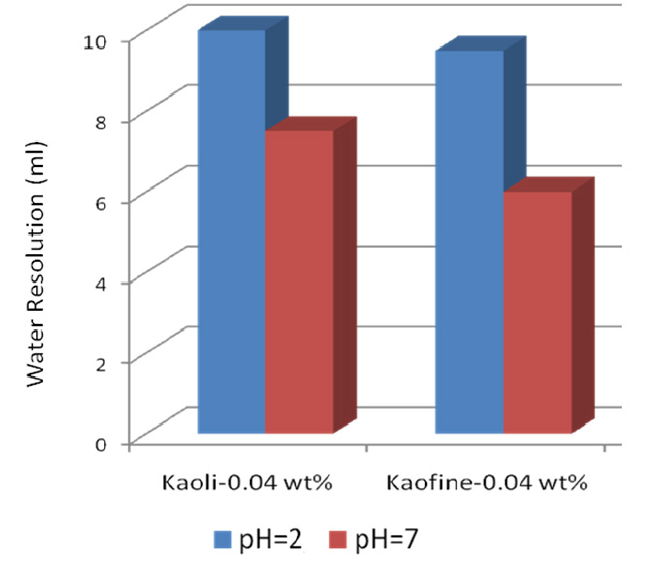
Figure 10. Bottle test of clay stabilized emulsions at pH~2 and pH~7.